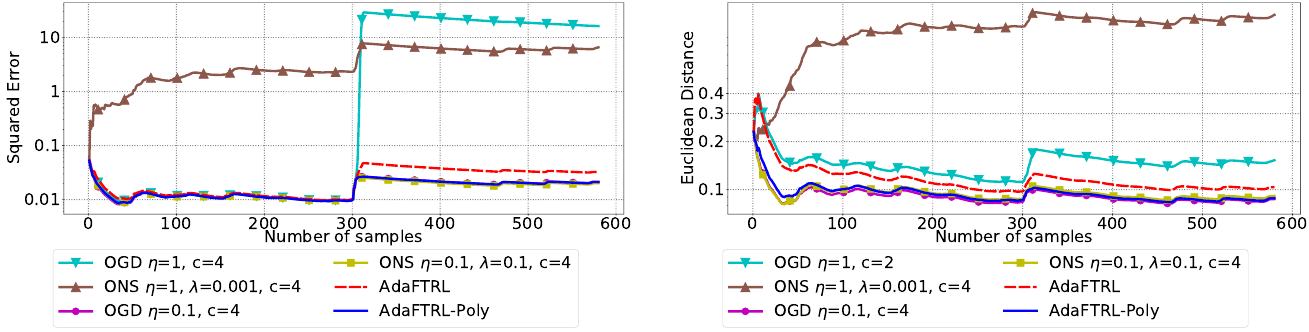
Figure 5. Results for Google Flu data.